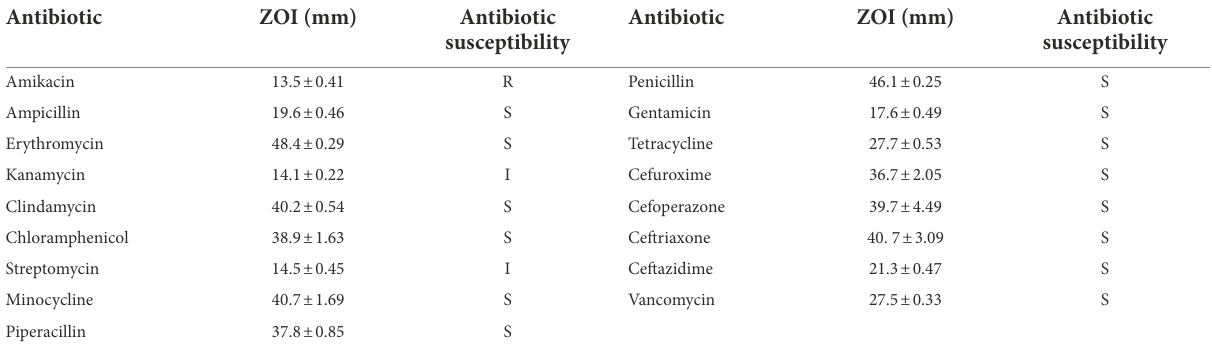
TABLE 3 Antibiotic susceptibility of selected antibiotics tested against R. intestinalis.